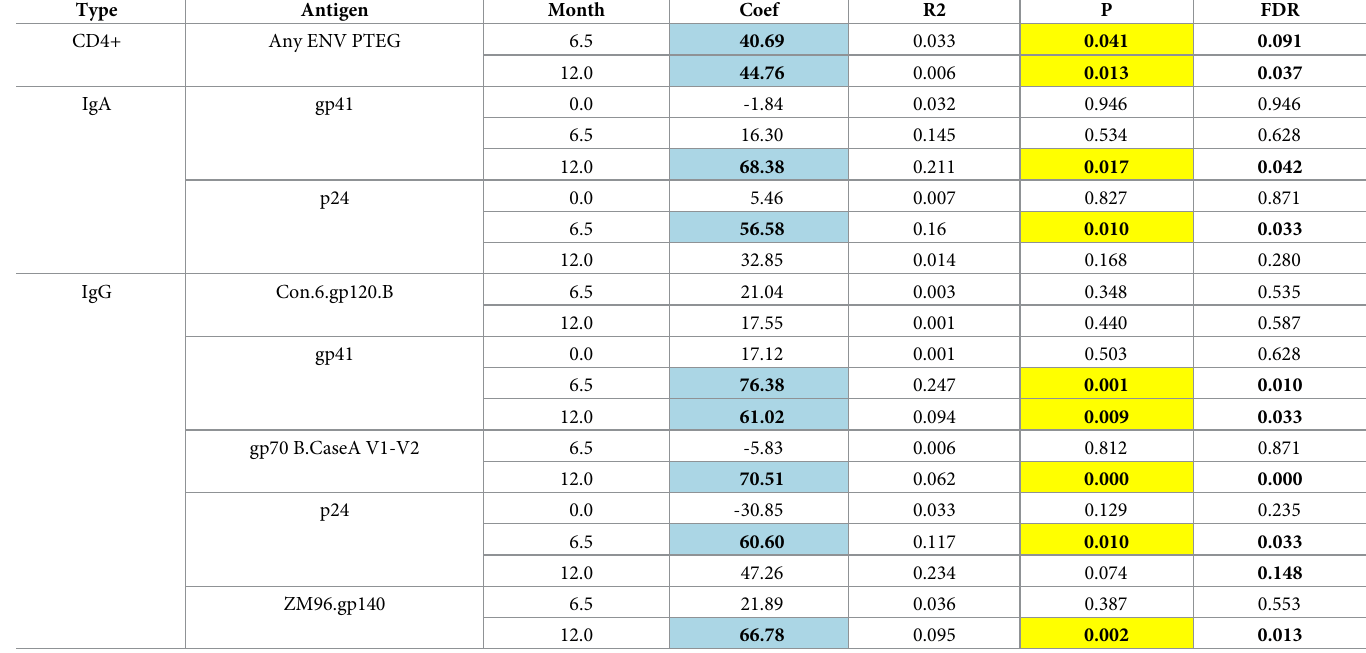
Table 2. Coefficients, R2 values and significance values of the relationship between alpha diversity and median-split immunogenicity responses calculated using the betta function in breakaway. Highlighting and FDR calculations were applied as described in Table 1. R2 values were calculated from the pearson correlation coefficient between alpha diversity and median split immunogenicity